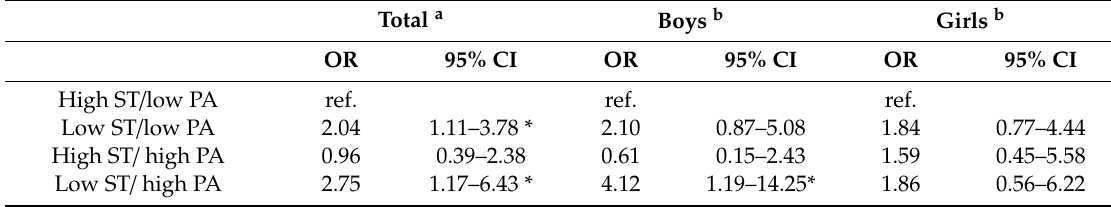
Table 2. Adjusted odds ratios of academic performance by physical activity and screen time categories. Total a OR 95% CI OR 95% CI OR ref.